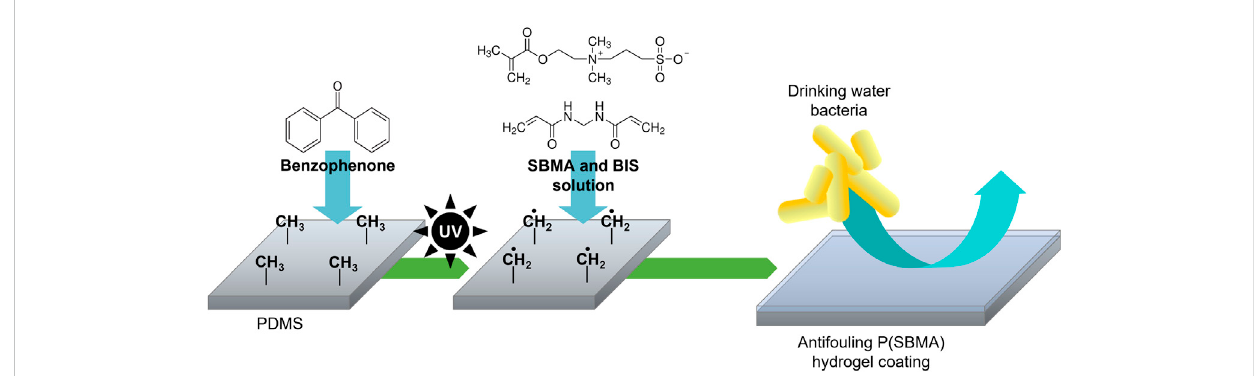
FIGURE 1 Schematic of the photografting process. UV-excitation of benzophenone infused into PDMS produces surface-bound methyl radicals that initiate polymerization of monomers present in a solution, which results in an anti-adhesive hydrogel coating covalently bound to the PDMS